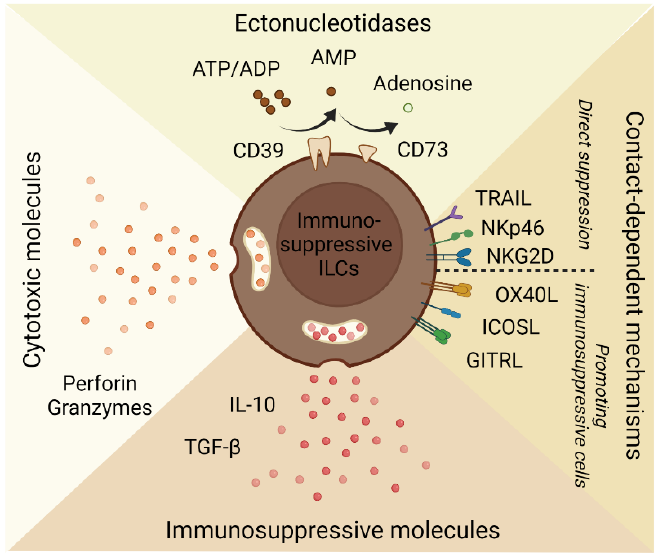
Figure 2. Mechanisms of immunosuppressive ILCs. Immunosuppressive ILCs have been shown to suppress immune responses through ectonucleotidases (e.g., CD39, CD73), killing of immune cells through cytotoxic molecules (e.g., perforins, granzymes) or contact-dependent mechanisms (e.g., TRAIL, NKp46, NKG2D), and soluble mediators (e.g., IL-10, TGF- β ). Immunosuppressive ILCs can promote other suppressor cells through expression of OX40L, ICOSL, and GITRL.